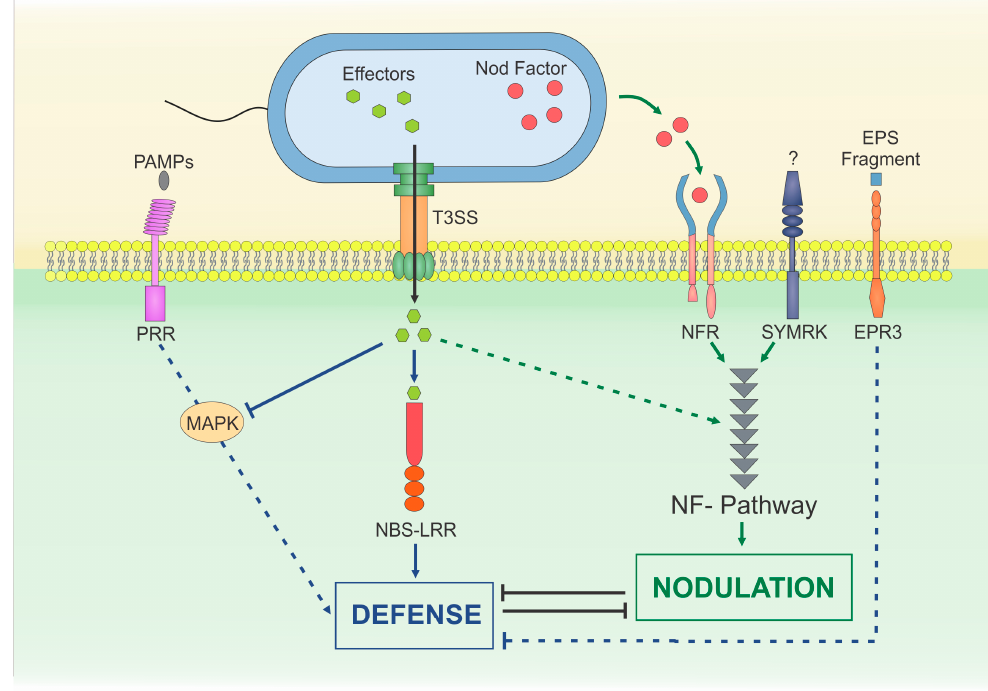
Figure 3. The interplay between nodulation and defense signaling pathways. Plants perceive bacterial molecules (pathogen-associated molecular patterns, PAMPs) using pattern recognition receptors (PPRs) that activate mitogen activated kinase (MAPK) cascades that trigger host defense responses. Adapted pathogens use the type III secretion system (T3SS) to deliver effector proteins into the cytosol of host cells. Bacterial effectors can inhibit the MAPK cascade, leading to suppression of host defenses. In some plants varieties, these effectors are recognized by nucleotide binding site- leucine rich repeat domains (NBS-LRR) receptors, which trigger a second tier of host defense responses. Recognition of Nod factors produced by compatible rhizobia by specific receptors (NFR) triggers a signaling cascade leading to nodulation (NF-Pathway). Rhizobial effectors can also promote nodulation by directly activating the NF-Pathway. The symbiosis receptor-like kinase (SYMRK) is also necessary for nodule formation, but the nature of its putative ligand is unknown. In a second stage of rhizobia recognition, exopolysaccharides (EPS) produced by rhizobia are perceived by exopolysaccharide protein receptor 3 (EPR3), inactivating the defense signaling pathway through unknown mechanisms.